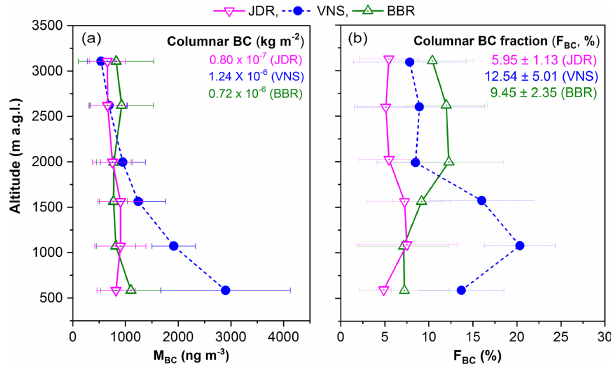
Figure 11. Vertical profiles of (a) mean values of BC mass concen- trations ( M BC ) and (b) BC mass fractions ( F BC ) at JDR, VNS and BBR.